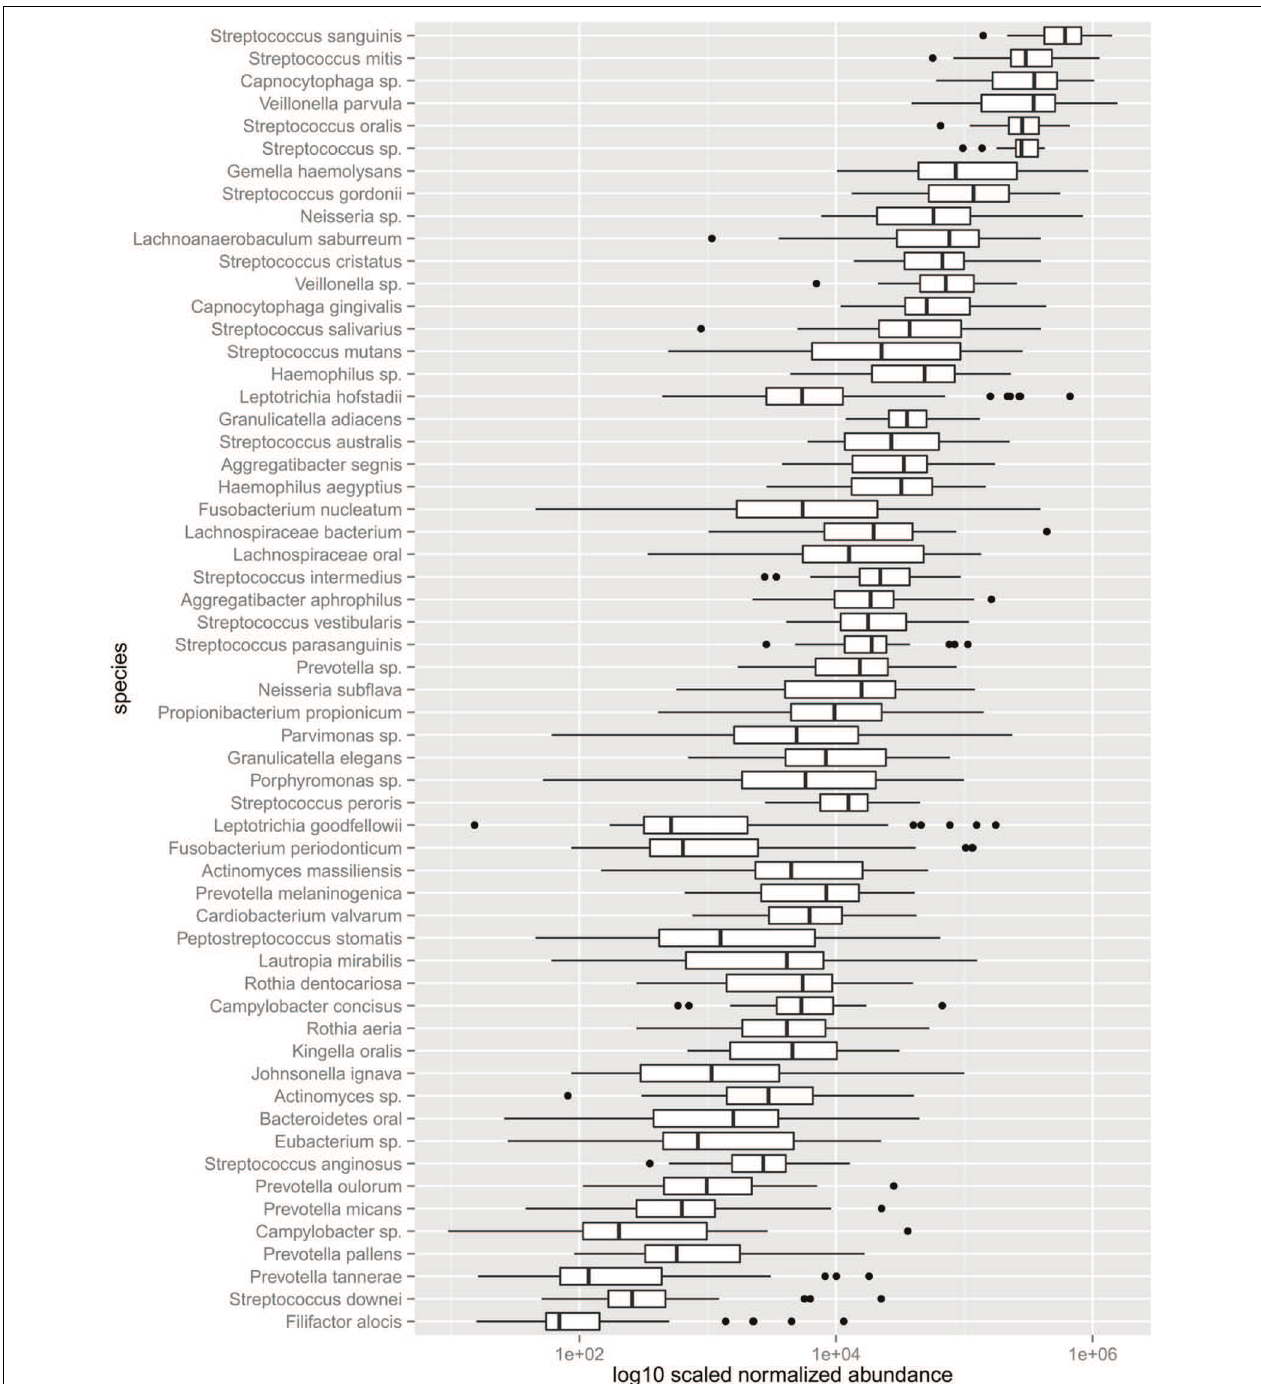
FIGURE 3 | Abundance of the dental plaque core microbiota. Box and whisker plot. Outliers shown as dots represent values 1.5 times great or less than the upper and lower quartile,